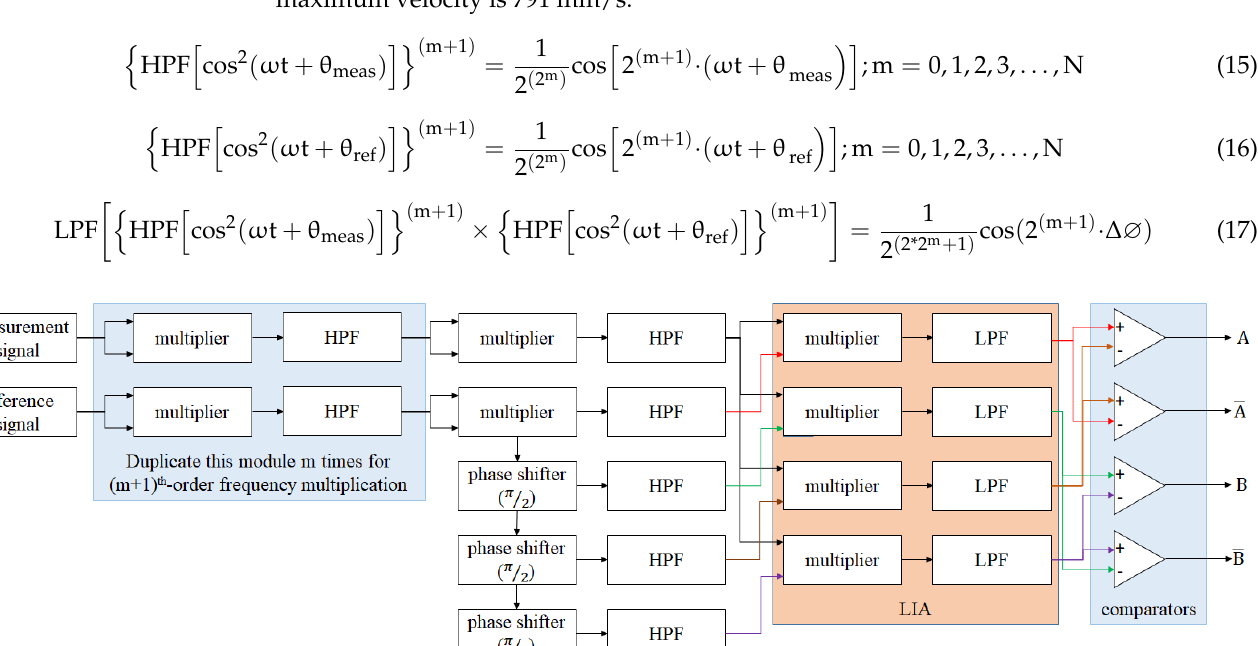
Figure 6. Block diagram of the multi − order analog interpolator.